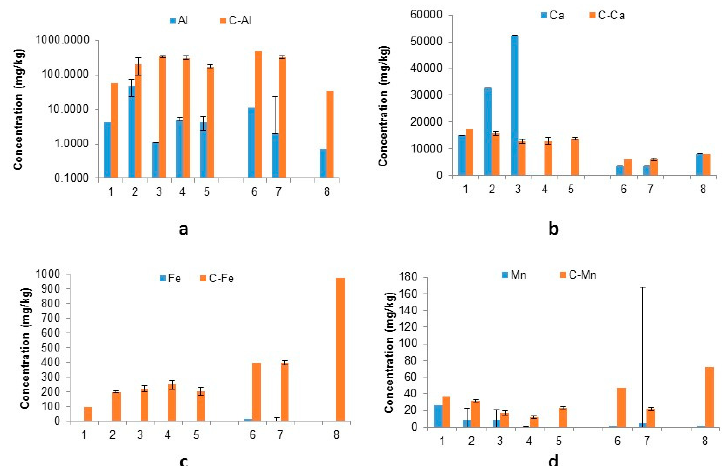
Figure 3. Concentration of: ( a ) Al, ( b ) Ca, ( c ) Fe and ( d ) Mn (mg / kg) in solution after water and citric acid leach (C-Element refers to citrate-leached results) (Samples: ESP dust: 1–5, BF sludge: 6–7, BOF sludge: 8).